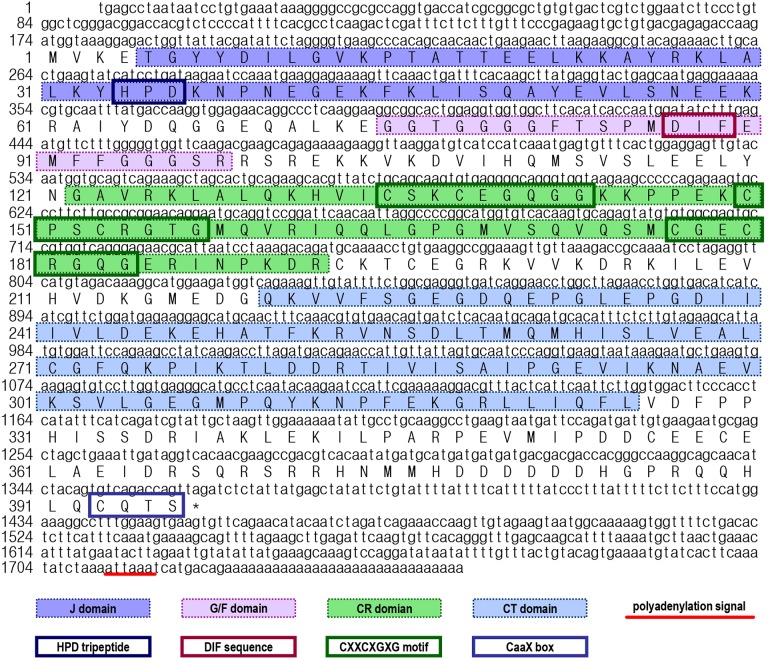
Nucleotide and deduced amino acid sequences of Litopenaeus vannamei HSP40 cDNA. The a.a. sequences deduced from the ORF are presented along with the corresponding cDNA sequence. The polyadenylation signal in the 3′-UTR is underlined, and the stop codon is marked by an asterisk. In the a.a. sequence, the N-terminal J domain, glycine/phenylalanine-rich (G/F) domain, cysteine-rich (C/R) domain, C-terminal (CT) domain, HPD tripeptide, DIF sequence, CXXCXGXG motifs and CaaX box are marked with different symbols.